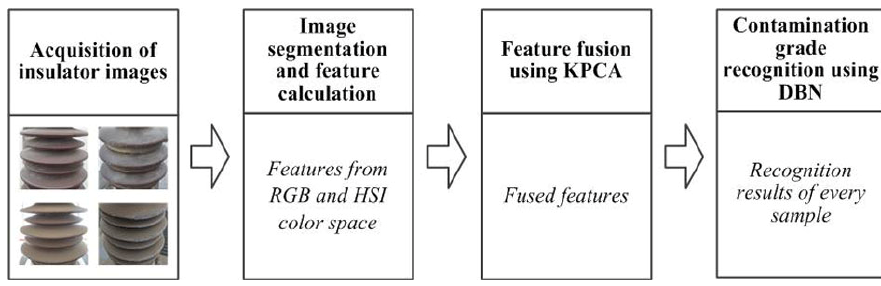
Figure 1. Process of insulator contamination grade recognition based on visual images.